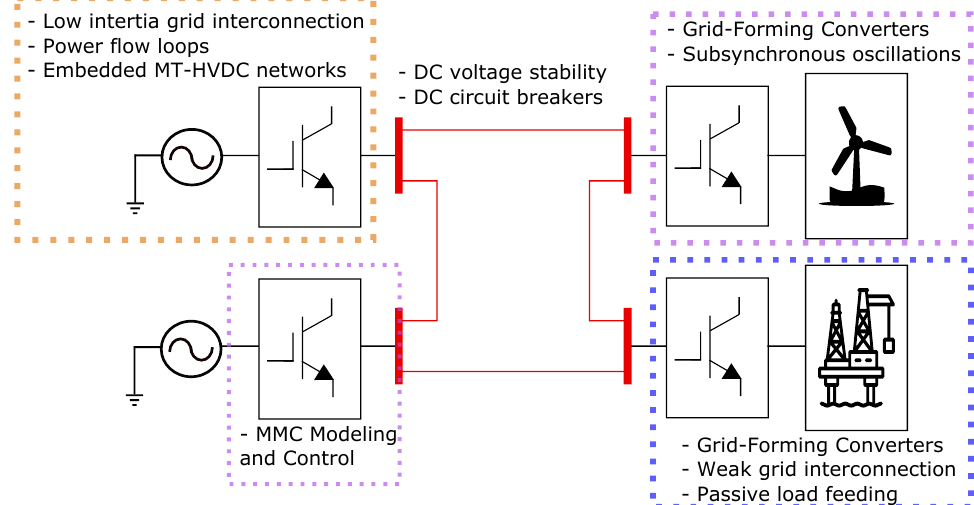
Figure 2. Open problems and challenges in the control and operation of MT-HVDC